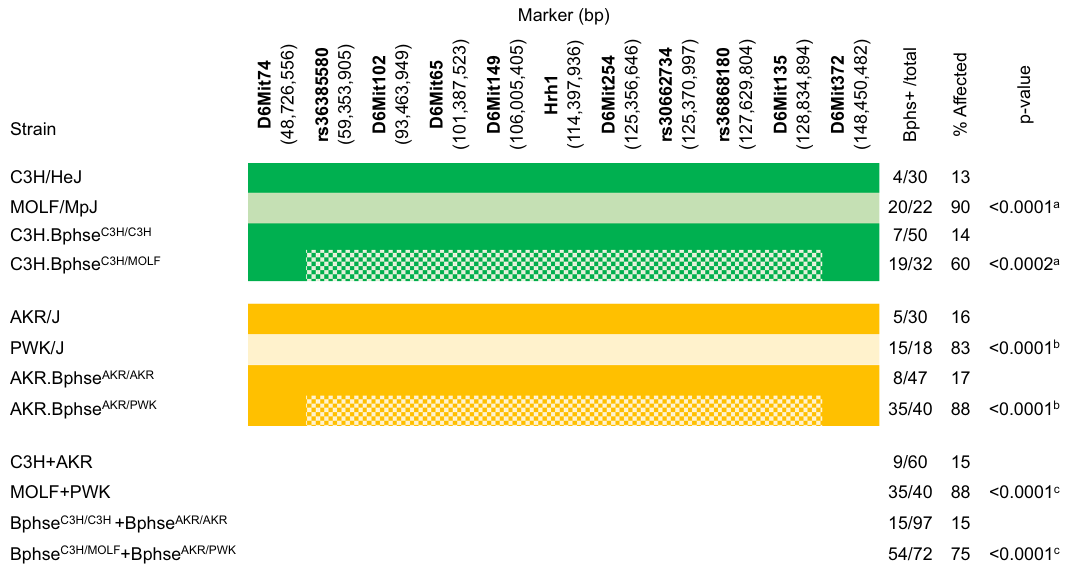
Fig. 1 Congenic mapping con fi rms linkage of Bphse to Bphs/Hrh1 . Mice were injected with 200 ng of PTX on D0. Three days later the animals were challenged with the indicated dose of HA (mg dry weight free base/kg body weight) by intraperitoneal injection and deaths recorded as number of animals dead/number of animals tested at 30 minutes post HA challenge. Marker loci and their location (mm10) are listed along with the respective genotypes: C = C3H, M = MOLF, A = AKR, P = PWK and He = heterozygous. a Relative to C3H/HeJ; b Relative to AKR/J; c Relative to C3H/HeJ and AKR/J